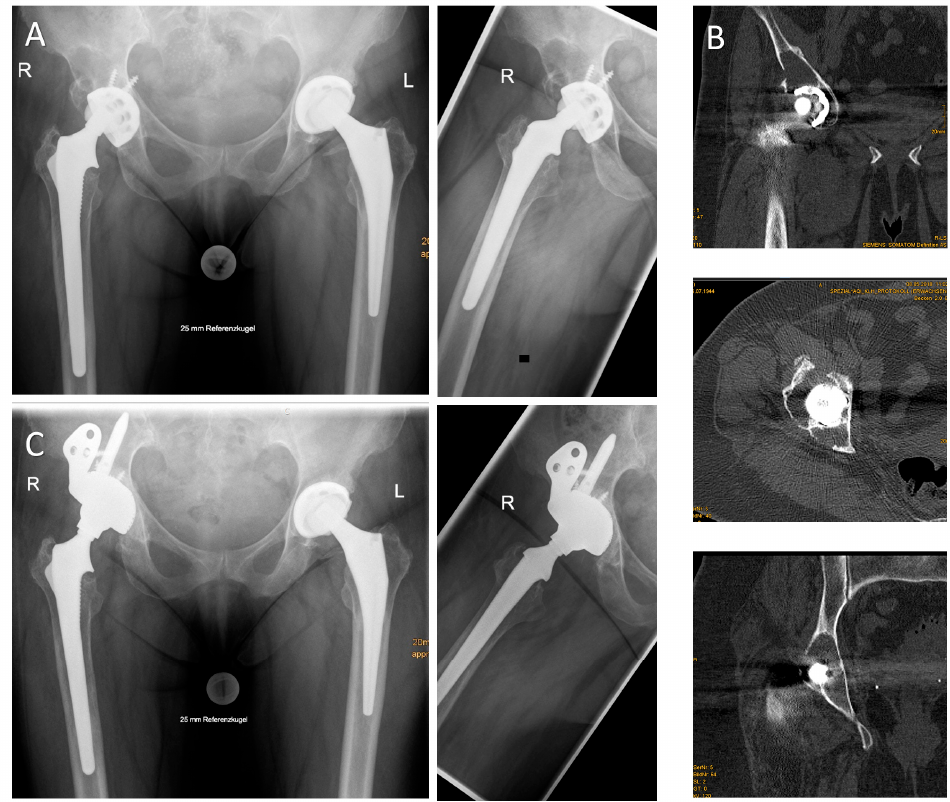
Figure 3. ( A ) A.p. and axial radiographs of an 81-year-old female patient with large periacetabular osteolyses due to wear debris 17 years after primary hip arthroplasty. ( B ) Multiaxial CT analyses revealed insufficient stability of both the anterior and posterior column. Intraoperatively, the large iliac defect was contained by an egg shell-like outer cortex. More than 60% of the acetabular rim was deficient. The iliac defect was filled with impacted allogenic bone chips and the asymmetric cup was augmented with a 50-mm intramedullary iliac press-fit stem and multiple screws. ( C ) Radiographic imaging 24 months postoperatively revealed a stable implant with well-integrated bone grafts (HHS: 46 preoperatively, 66 postoperatively; OT 150 min).